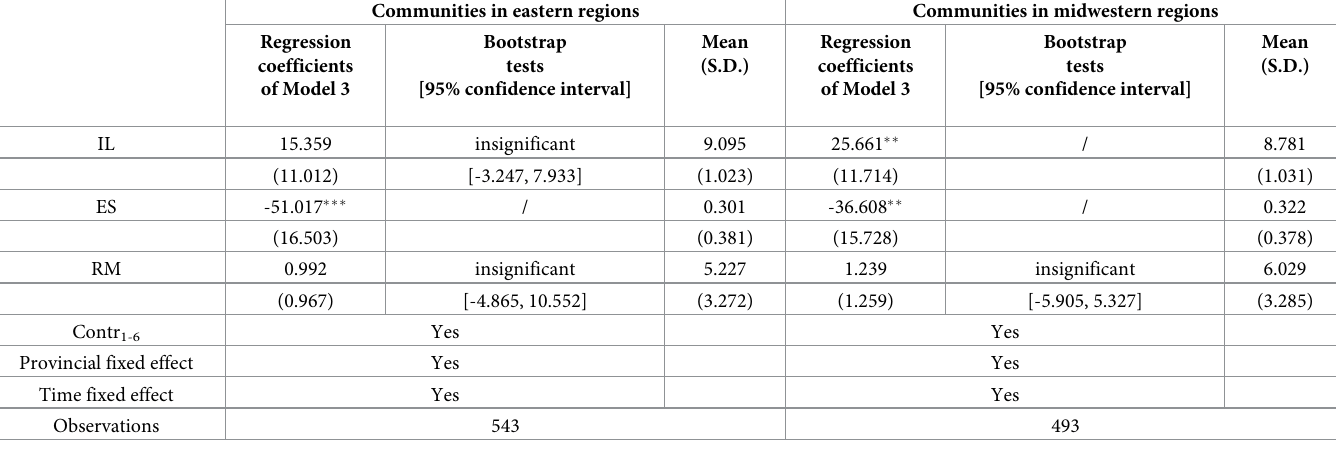
Table 6. The regression and bootstrap test results of the mediating effects in eastern and midwestern regions a .